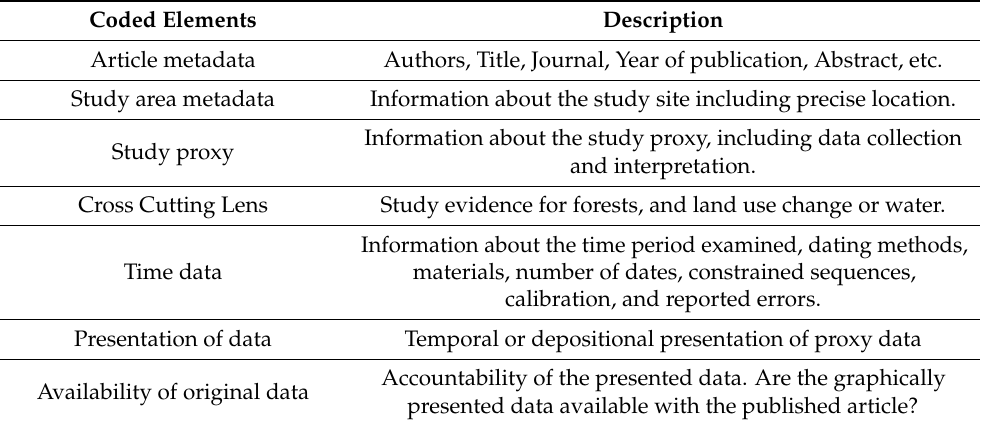
Table 5. Data coding and extraction for studies that met the inclusion criteria at